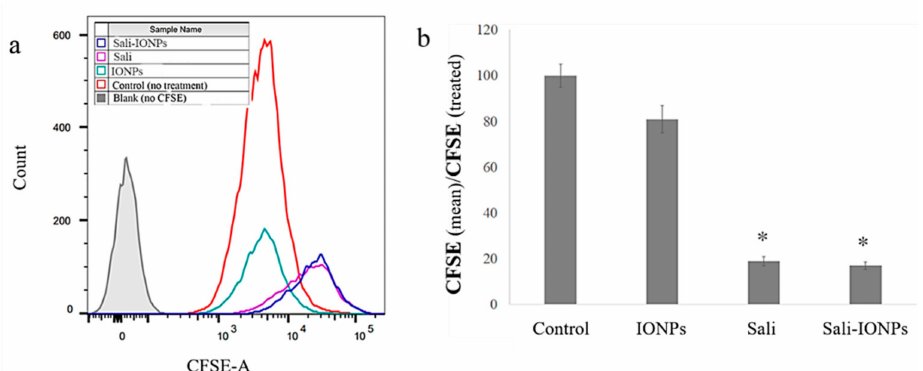
Figure 7. Cell proliferation analysis of carboxyfluorescein succinimidyl ester (CFSE)-labelled U251 upon treatment with IONPs, salinomycin, and Sali-IONPs: ( a ) CFSE flow cytometry graph and ( b ) the relative cell proliferation inhibition by mean CFSE control / mean CFSE treated . Note: * indicates a significant di ff erence compared to the control group at p <